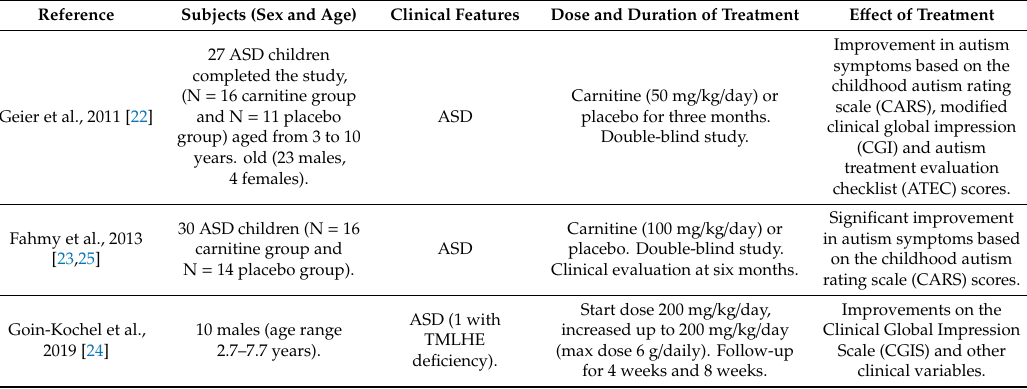
Table 1. E ff ects of carnitine treatment in non-syndromic